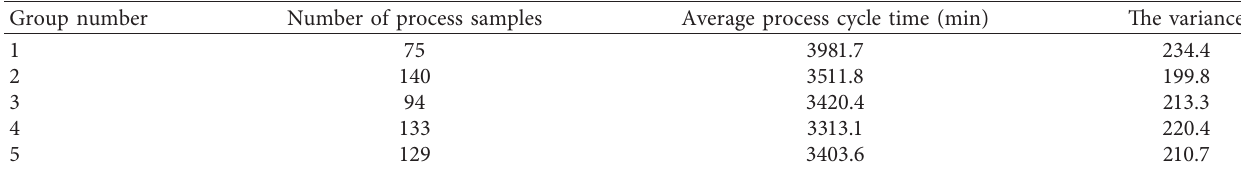
Table 9: Simulation results of freight flow after